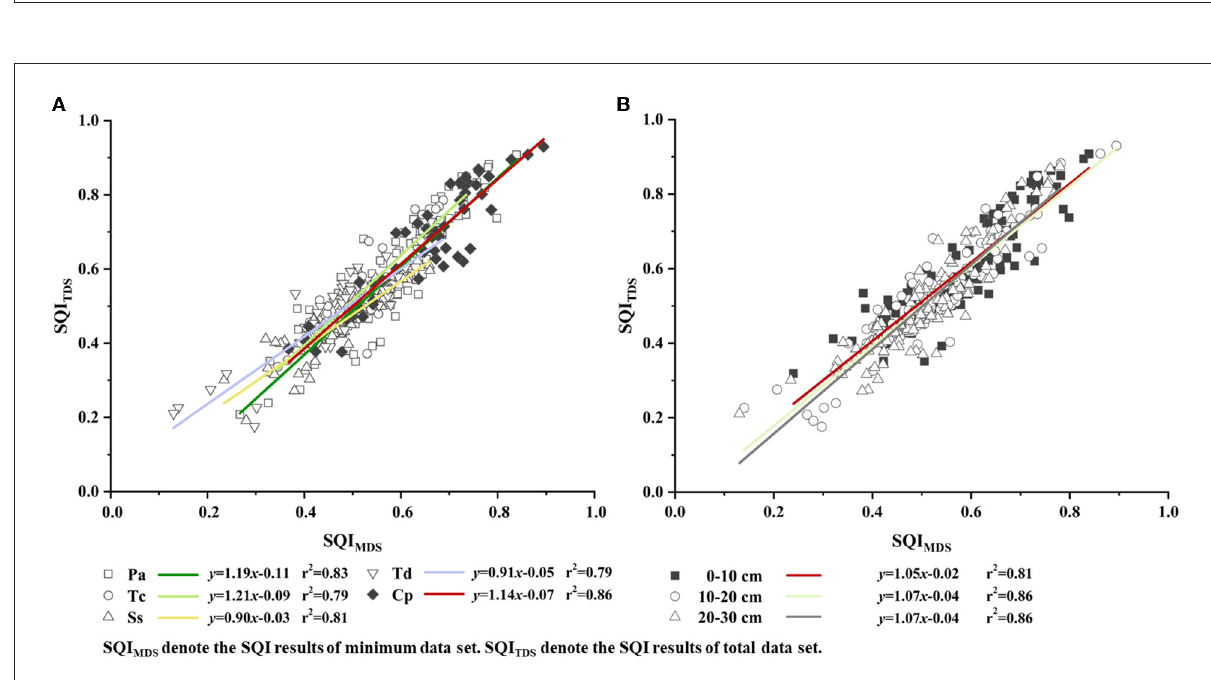
FIGURE5 The linear regression and determination coefficient (r 2 ) of SQI MDS and SQI TDS under different vegetation types (A) and soil depth (B)